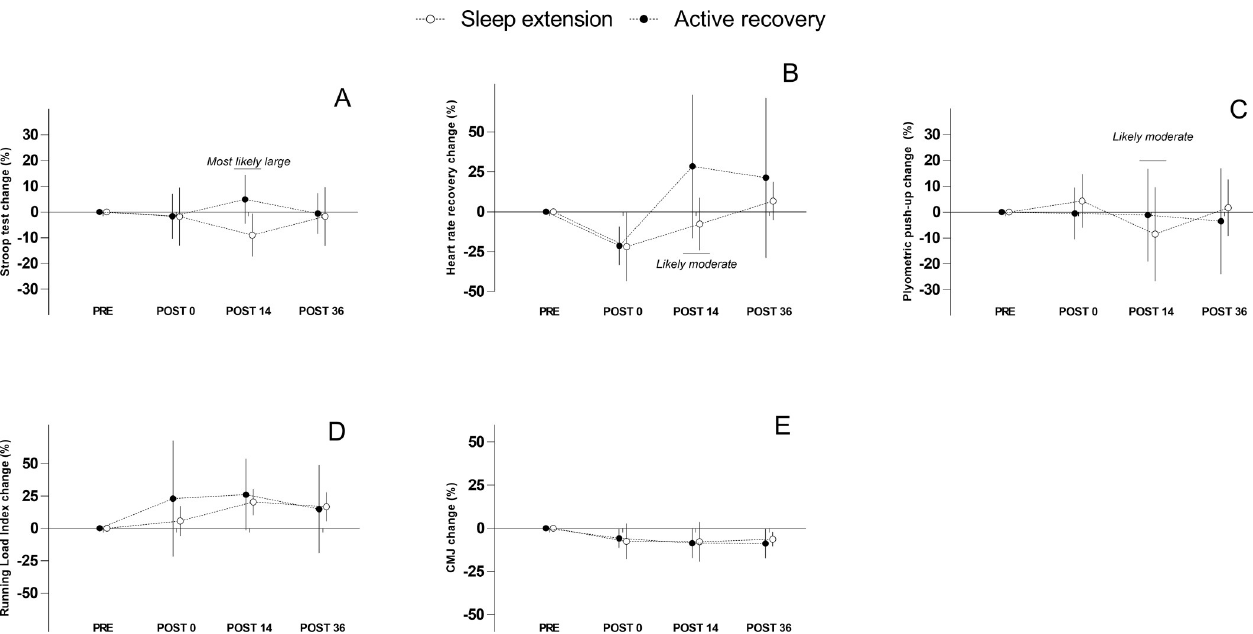
Fig 5. Between group comparison for physical and cognitive markers. White and black dots represent the sleep extension and active recovery group respectively. Error bars represent standard deviations. Figure A: Stroop test. Figure B: Heart rate recovery. Figure C: Plyometric push-up. Figure D: Running load index. Figure E: Counter movement Jump.